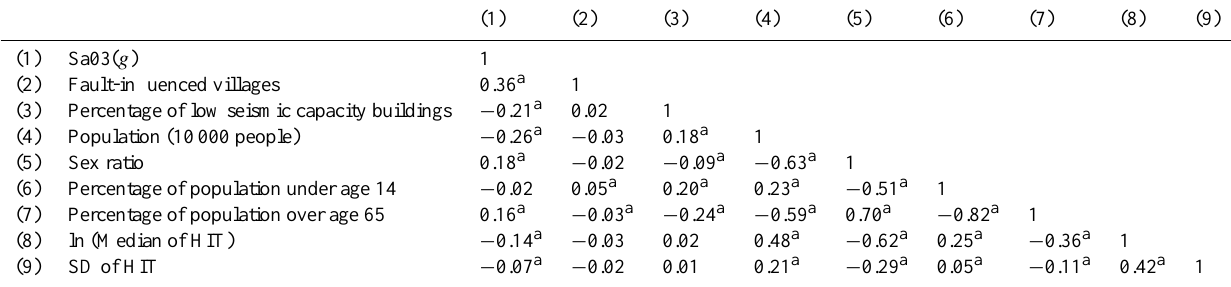
Table 2. Simple correlations among independent